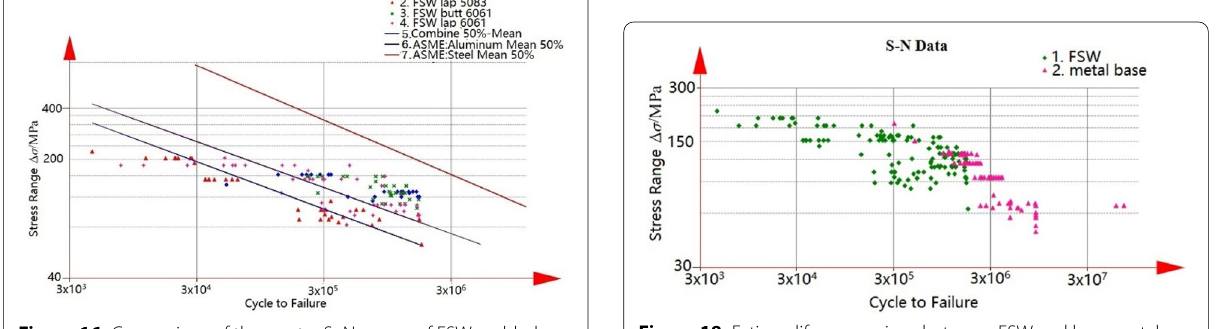
Figure 16 Comparison of the master S–N curves of FSW, welded steel, and aluminum